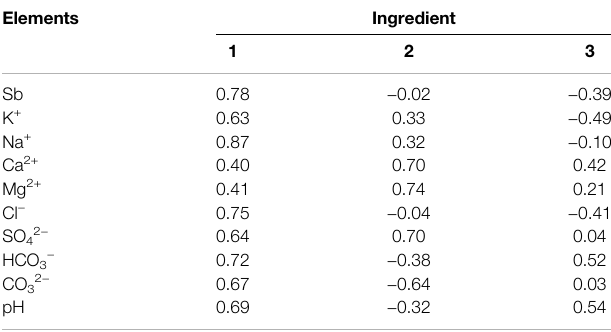
TABLE 4 | Composition matrix and common factor variance in the study